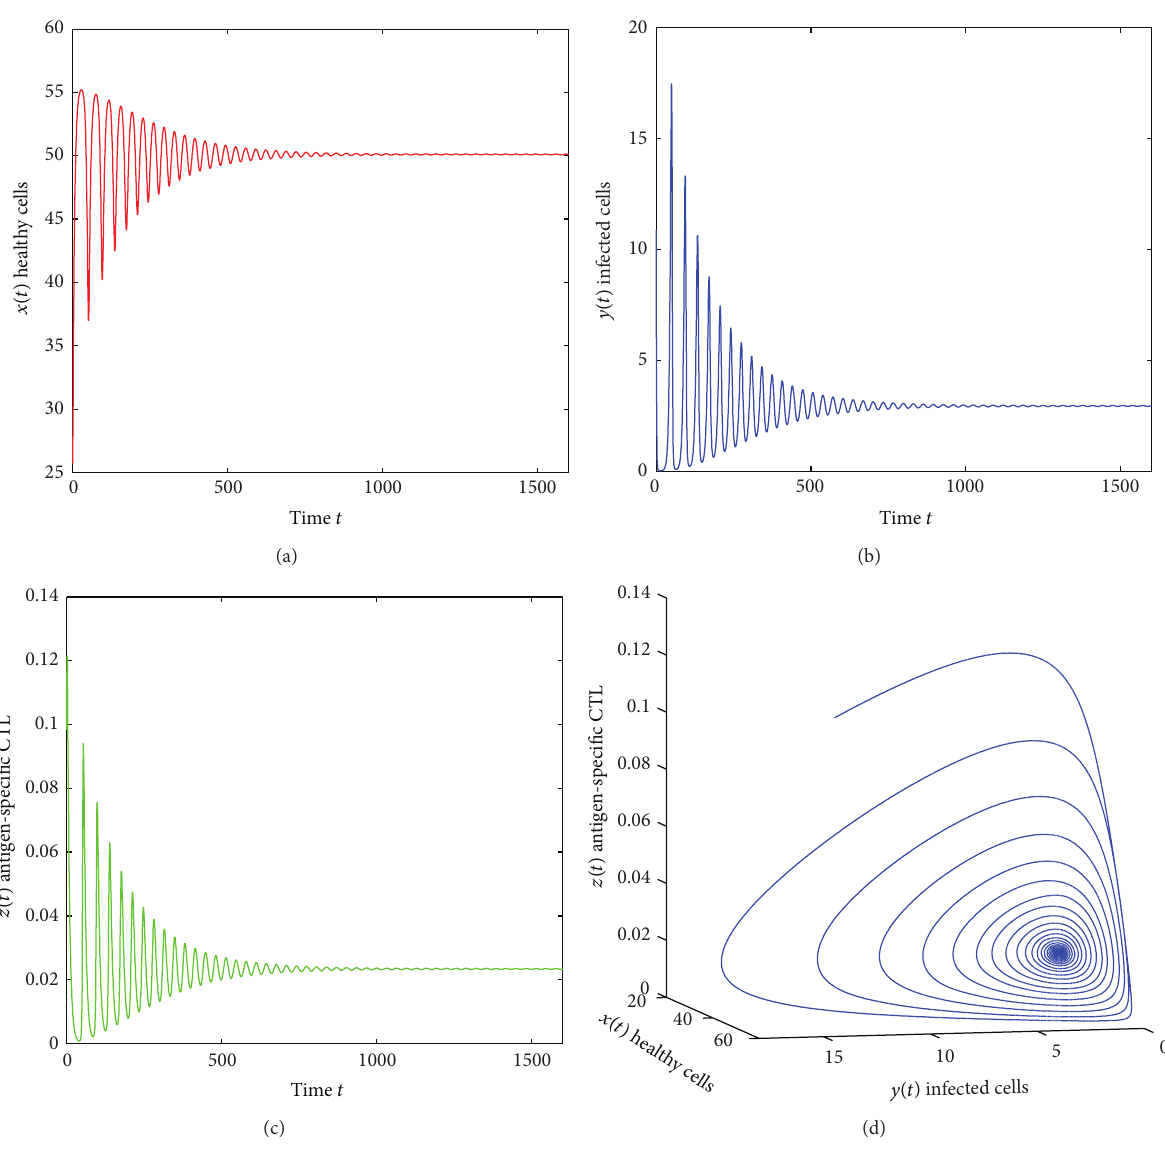
Figure 4: The diagrams show the approximate solutions of 𝑥(𝑡) , 𝑦(𝑡) , and 𝑧(𝑡) for 𝛼 = 1 in condition of 𝑅 1 > 1 and 𝐷(𝑃) < 0 . The panel (a) corresponds to healthy cells, (b) to infected cells, and (c) to antigen-specific CTL. The panel (d) shows the three-dimensional trajectory of system (5) with time